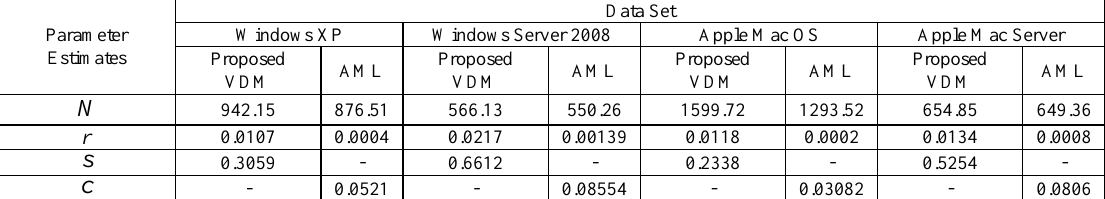
Table 1. Model parameter estimation results